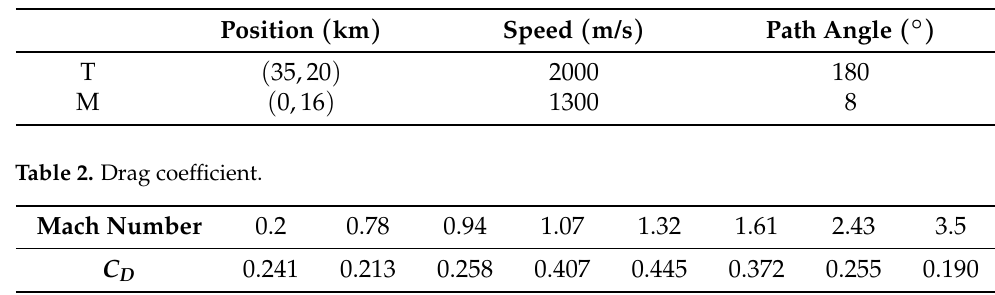
Figure 2. Simulation block diagram of FOFPR guidance law. Table 1. Initial condition of the missile and the hypersonic vehicle.